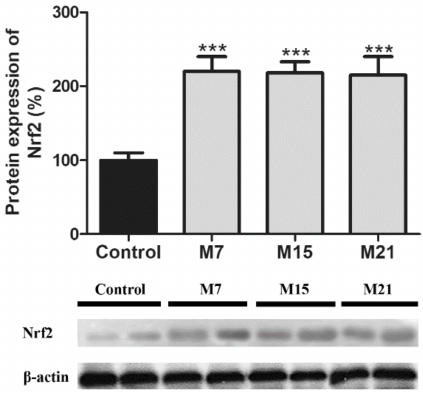
Figure 5. Protein expression of nuclear factor erythroid 2-related factor 2 (Nrf2) in rat brown adipose tissue of the control (black) and hypothyroid groups (gray) treated with methimazole for 7 (M7), 15 (M15), and 21 (M21) days, respectively. The protein content is expressed as a percentage from the control. Band images from a representative blot of three trials are shown. Bars represent the mean ± SEM. Compared to control, *** p <